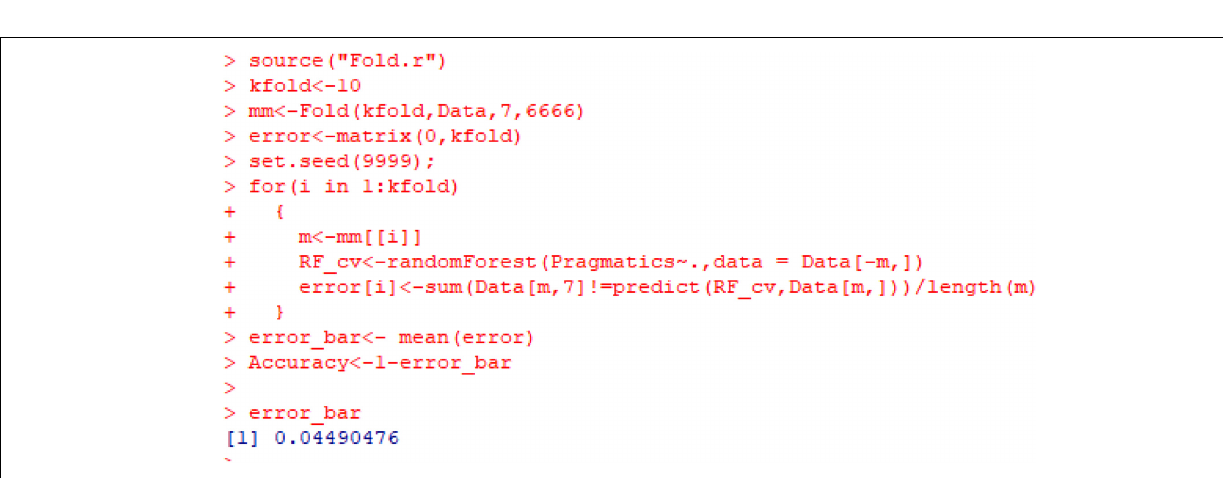
FIGURE 15 | Result of K-fold cross-validation of the performance of the established classification